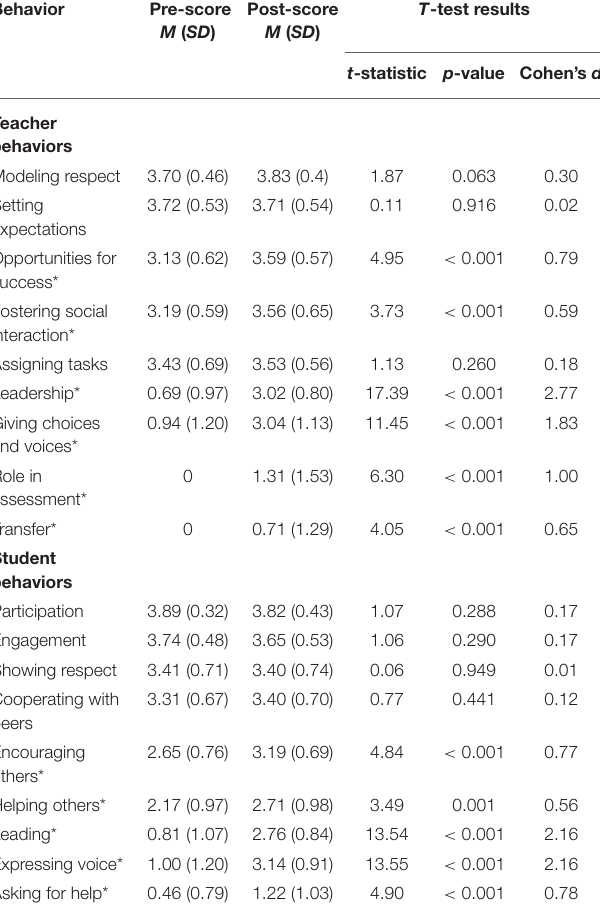
TABLE 2 | Pre- and post-TARE 2.0 ratings of teacher and student behaviors for the control